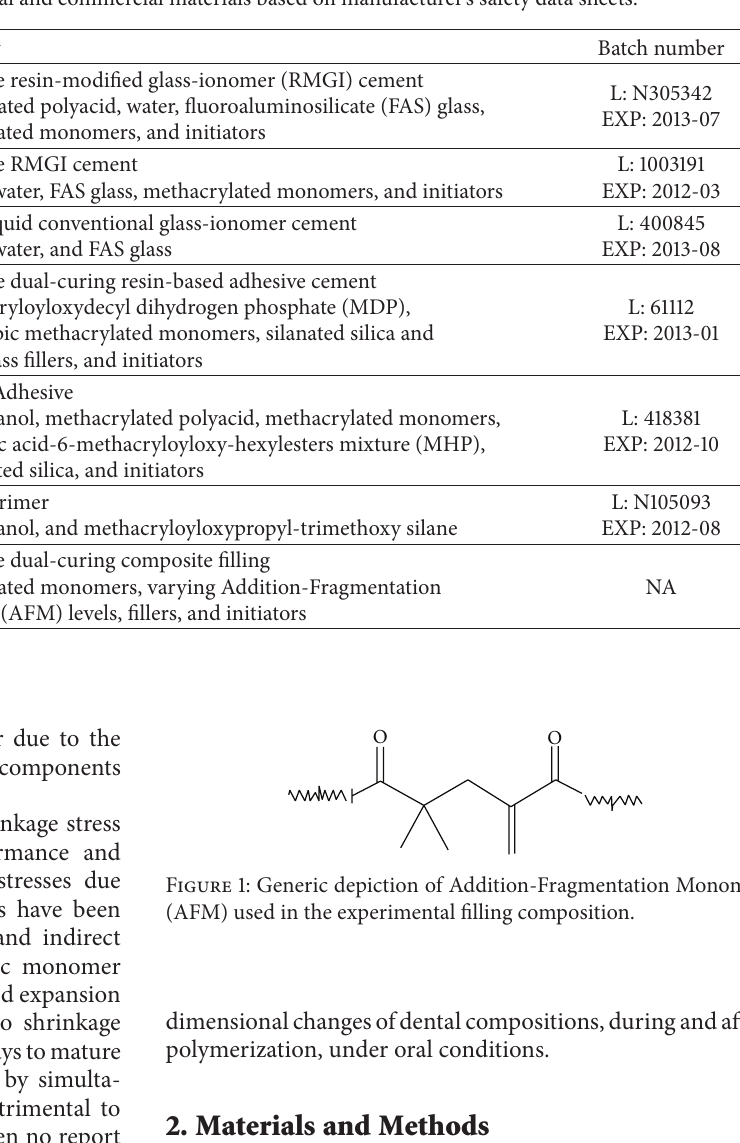
Table 1: Description of the experimental and commercial materials based on manufacturer’s safety data sheets.